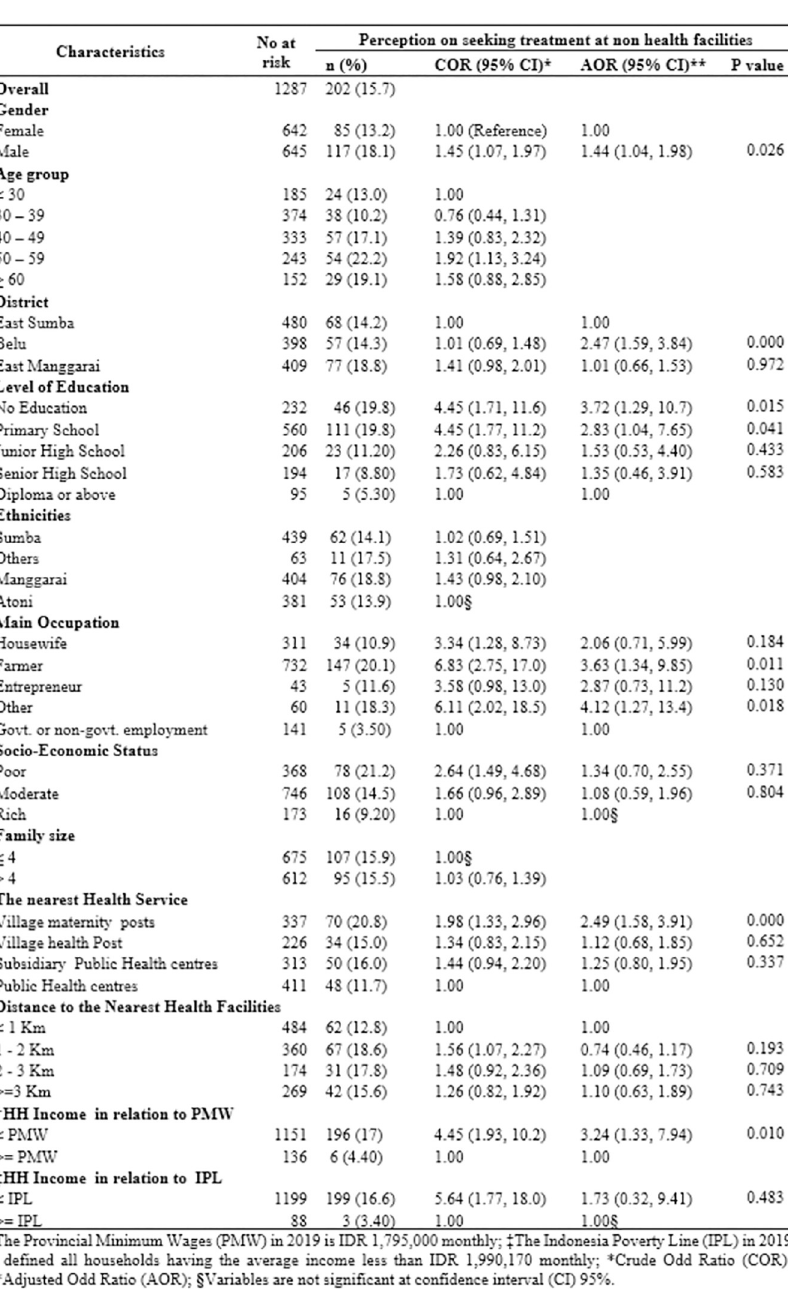
Fig 3. The level of perception on seeking malaria treatment in non-health facilities by different sociodemographic and environmental characteristics in the East Nusa Tenggara Province, Indonesia (n = 202).